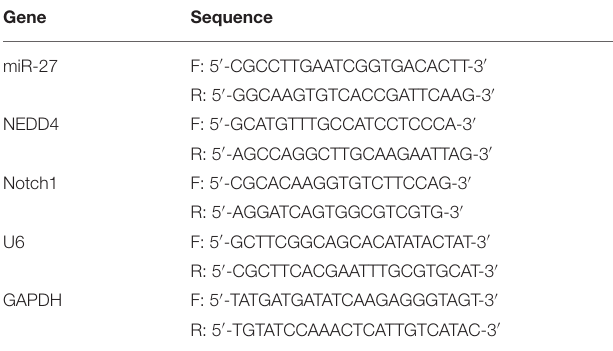
TABLE 1 | RT-qPCR primer